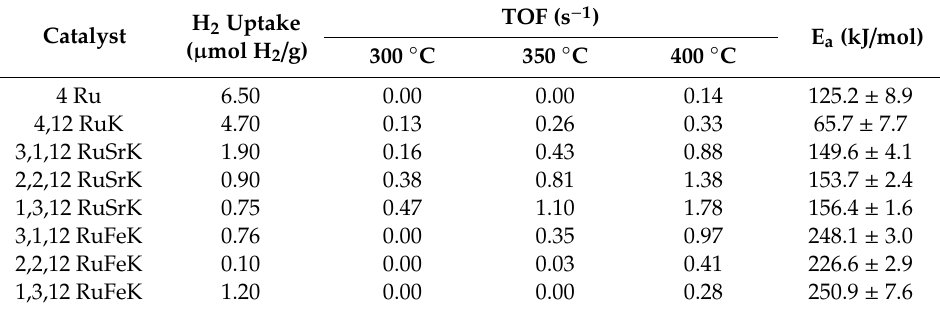
Table 1. H 2 uptake, turnover frequencies (TOF) and apparent activation energies (E a ) for Sr and Fe substituted catalysts as compared to 4,12 RuK and unpromoted 4 Ru